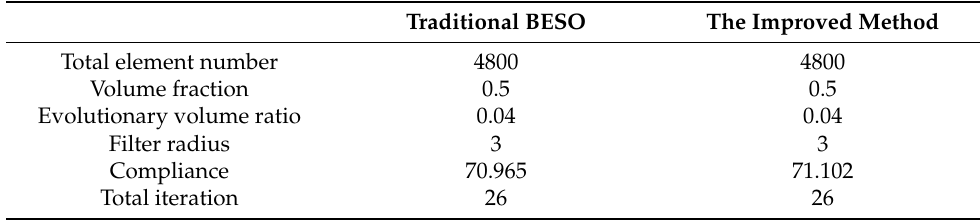
Table 2. Results for topology optimization of L-shaped beam.